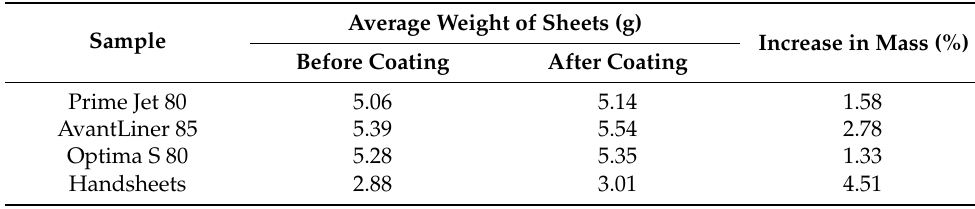
Table 1. Arithmetic average weights of paper samples before and after